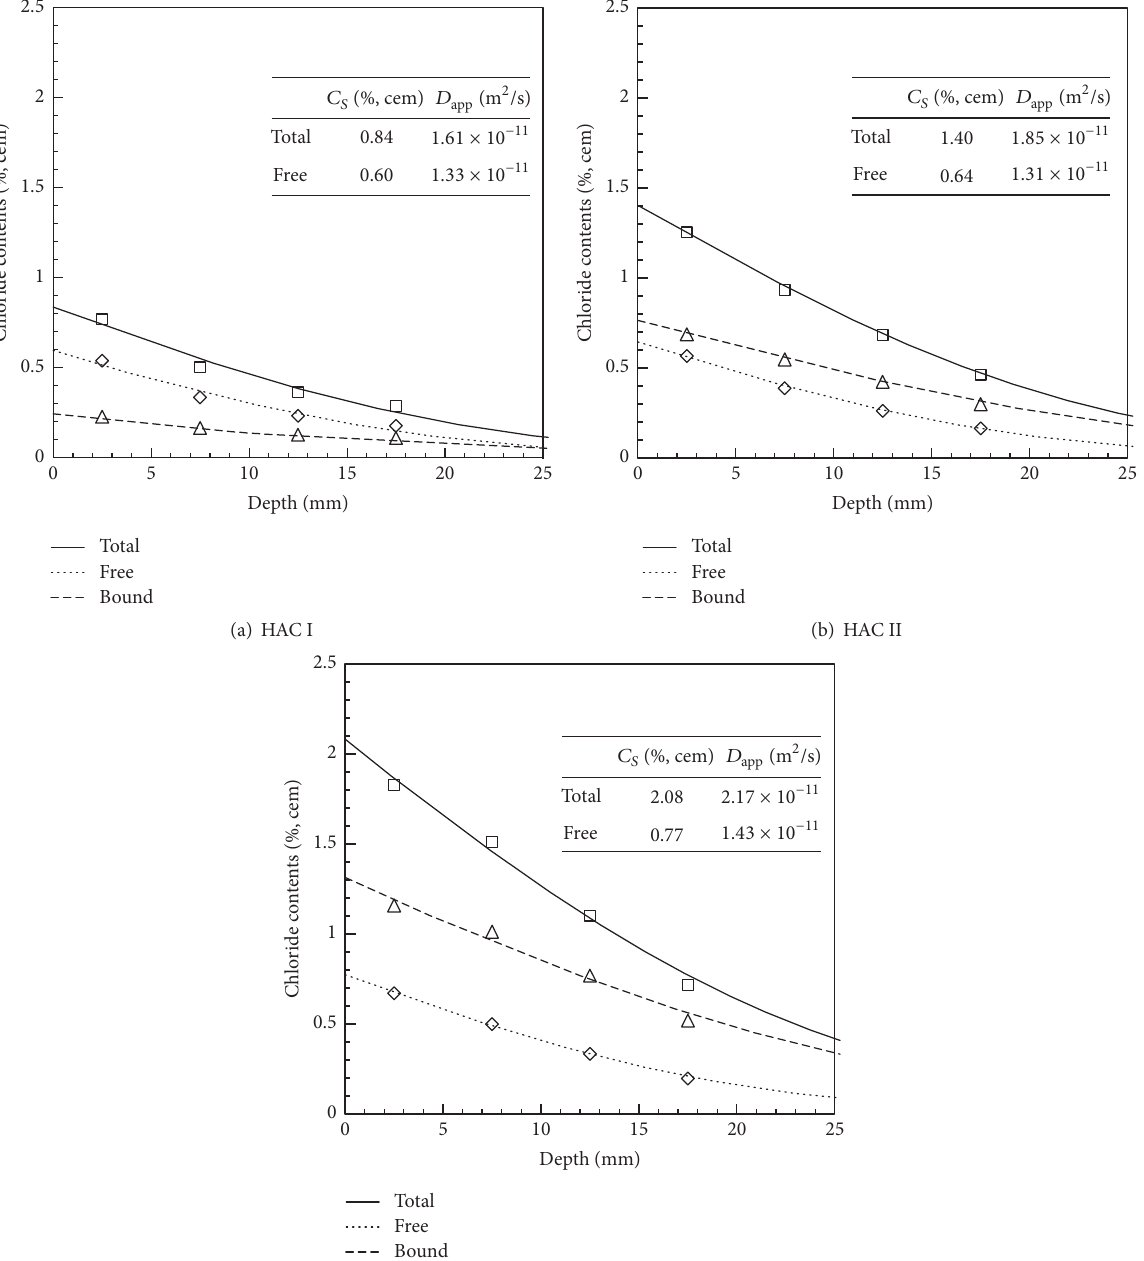
identical between HAC pastes, imposing similar